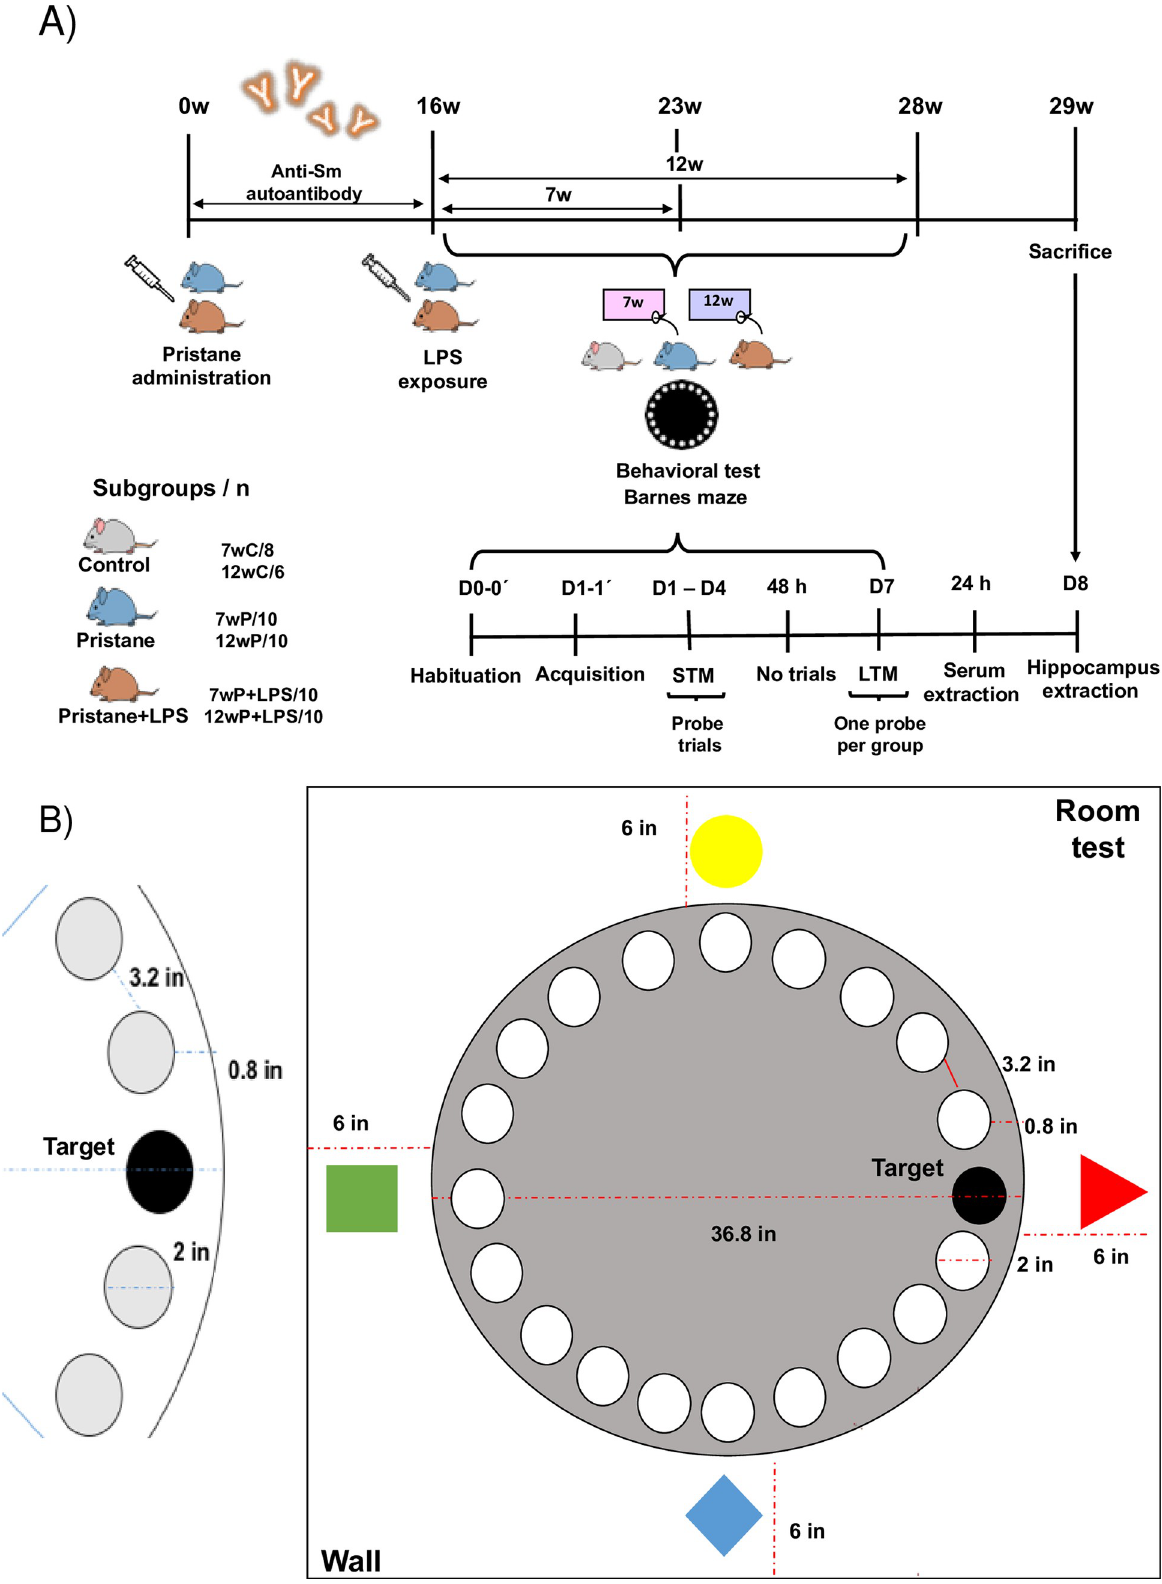
Fig 1. Eschematic representation of the experimental procedures in tested groups and Barnes maze test. A) Time point experimental procedures, behavioral test using Barnes maze and B) Eschematic design of Barnes maze platform. Abbreviatures: w = weeks, C = control, P = Pristane, P+LPS = Pristane plus LPS, D = day, h = hours, STM = short-term memory, LTM = long-term memory, in = inches. https://doi.org/10.1371/journal.pone.0217190.g001 PLOS ONE | https://doi.org/10.1371/journal.pone.0217190 September 9,